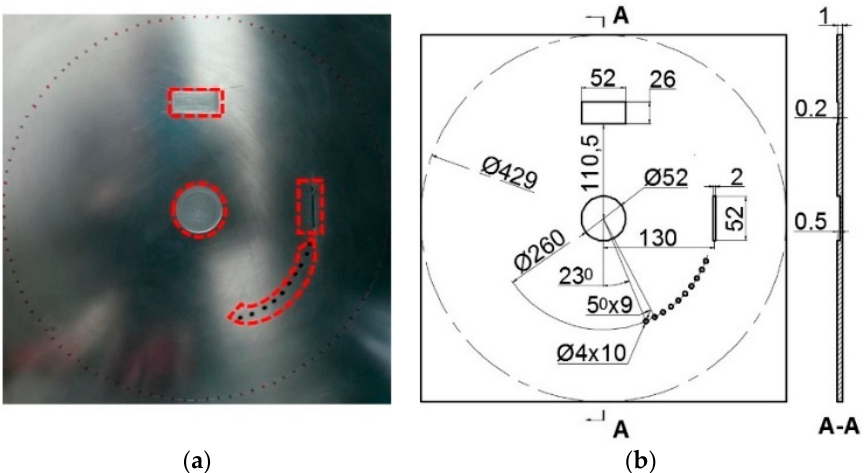
Figure 25. Image reconstruction of specimen #2: ( a ) Multidefect specimen; ( b ) Multidefect specimen drawing (Unit: mm).